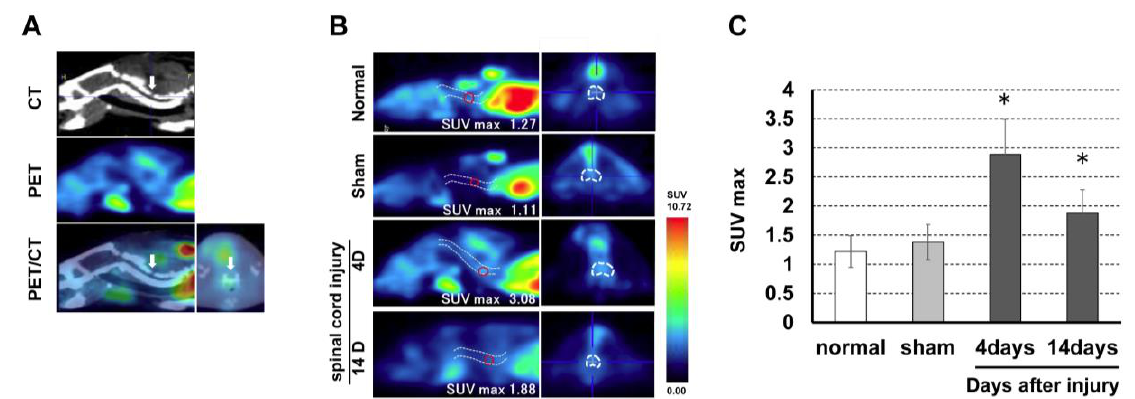
Figure 3. ( A ) PET and CT fusion images were created to detect the laminectomy level. ( B ) (R) - [ 11 C]PK11195 PET images in the rat spinal cord injury model. ( C ) (R) -[ 11 C]PK11195 uptake at the lesion level peaked at 4 days after SCI and was significantly higher compared to uptake in the control and sham groups. * p < 0.05.